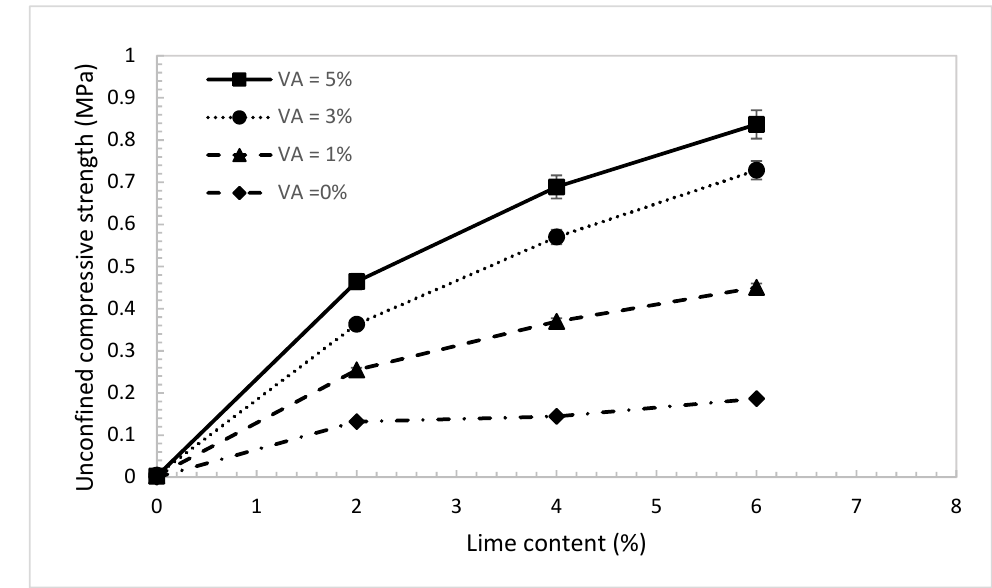
Figure 10. Unconfined compressive strength of the treated dune sand vs. different lime content. Two factor multi-level statistical analysis were performed to find out the statistical significance of the results of the effects of lime and volcanic ash on UCS [54]. Coefficients of variance calculated for lime and volcanic ash treatments, using the nine test samples, on the UCS response are 13.8 and 6.9, respectively. The P values, which are the measure of confidence on the truth of the null hypothesis (H o ), are calculated for both the effects of lime and VA on the UCS response. The statistically calculated P lime and P VA values for the UCS data are 0.001 and 0.0103, respectively. The P value for the lime is by an order of magnitude smaller than the traditional cutoff value for the meaningful